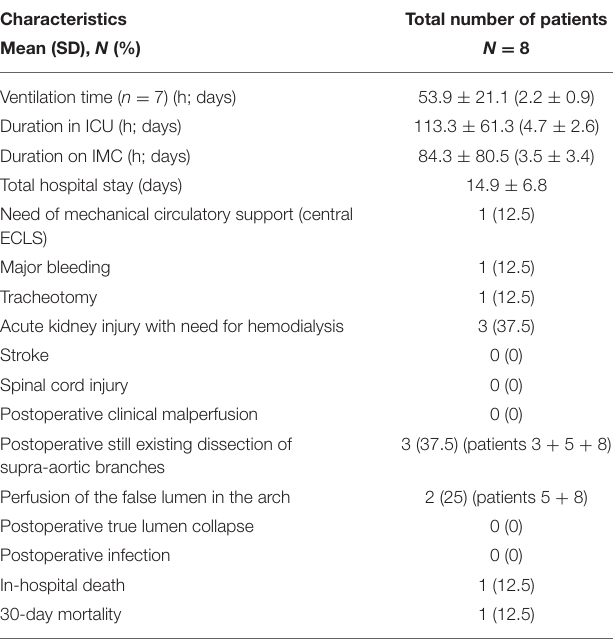
TABLE 4 | Postoperative outcome.